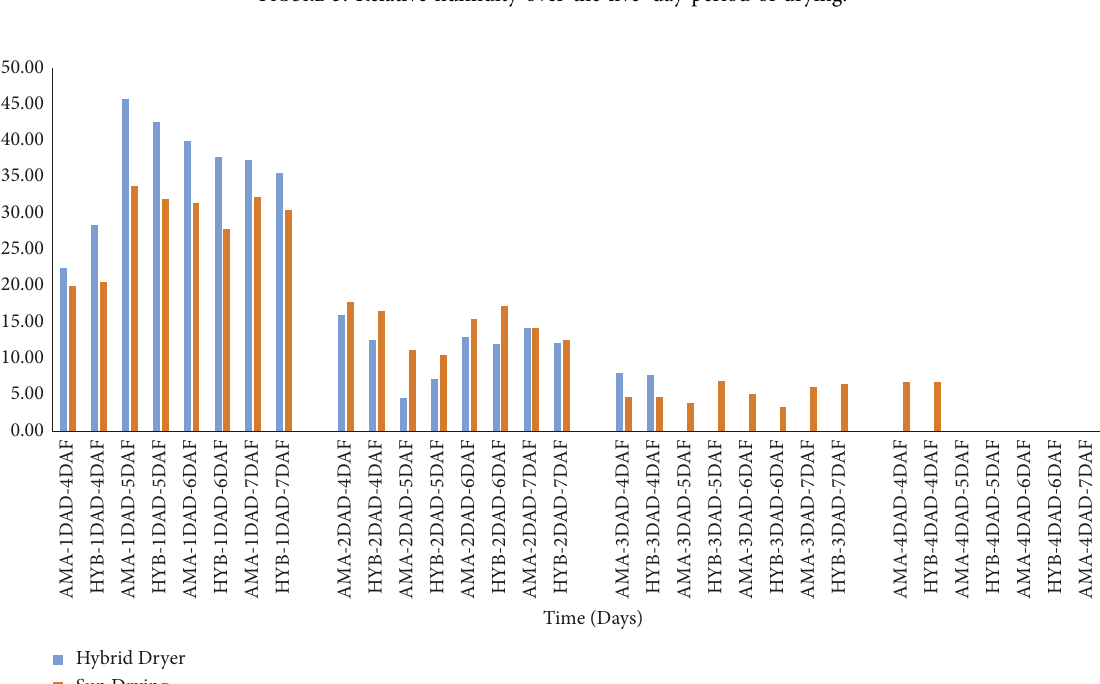
Figure 3: Relative humidity over the five–day period of drying.